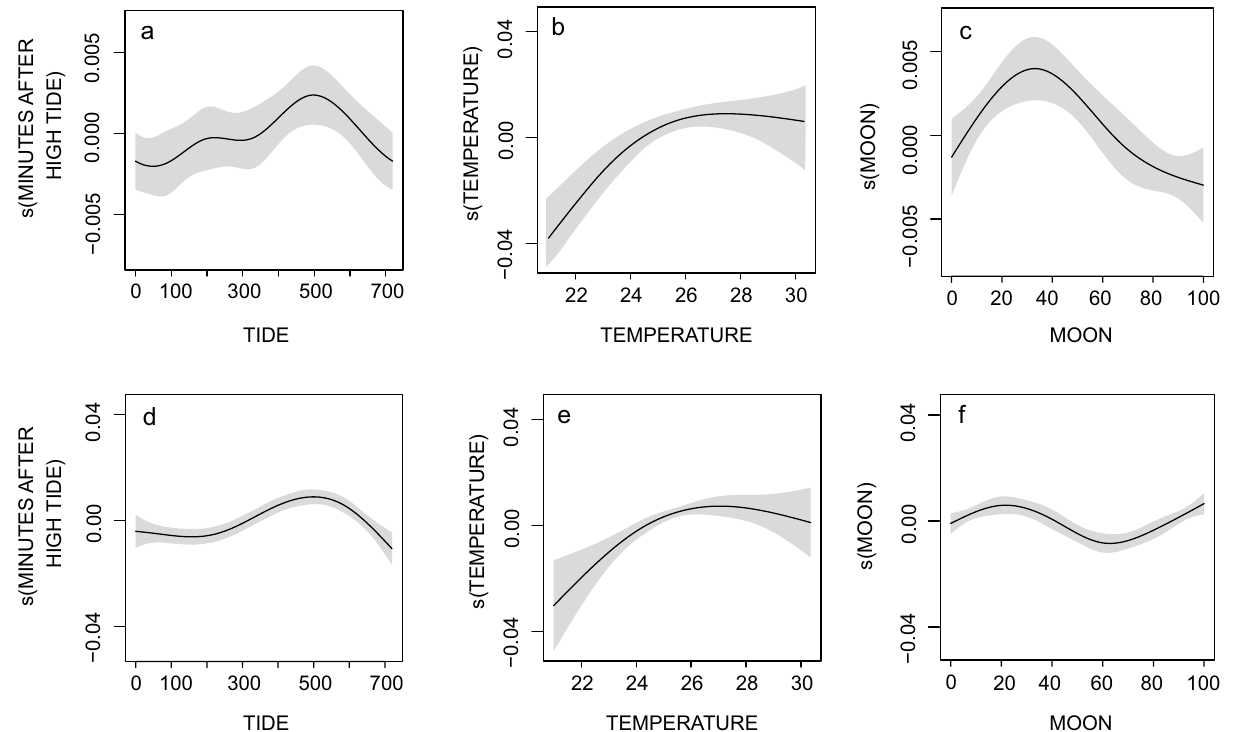
Figure 5. Generalized additive model (GAM) plots showing the partial effects of the minute after high tide, water temperature and the moon illumination on the frequency of bull ( a – c ) and oceanic blacktip ( d – f ) shark detections events at receiver locations throughout the Inhambane province of southern Mozambique. Shaded areas indicate the 95% confidence